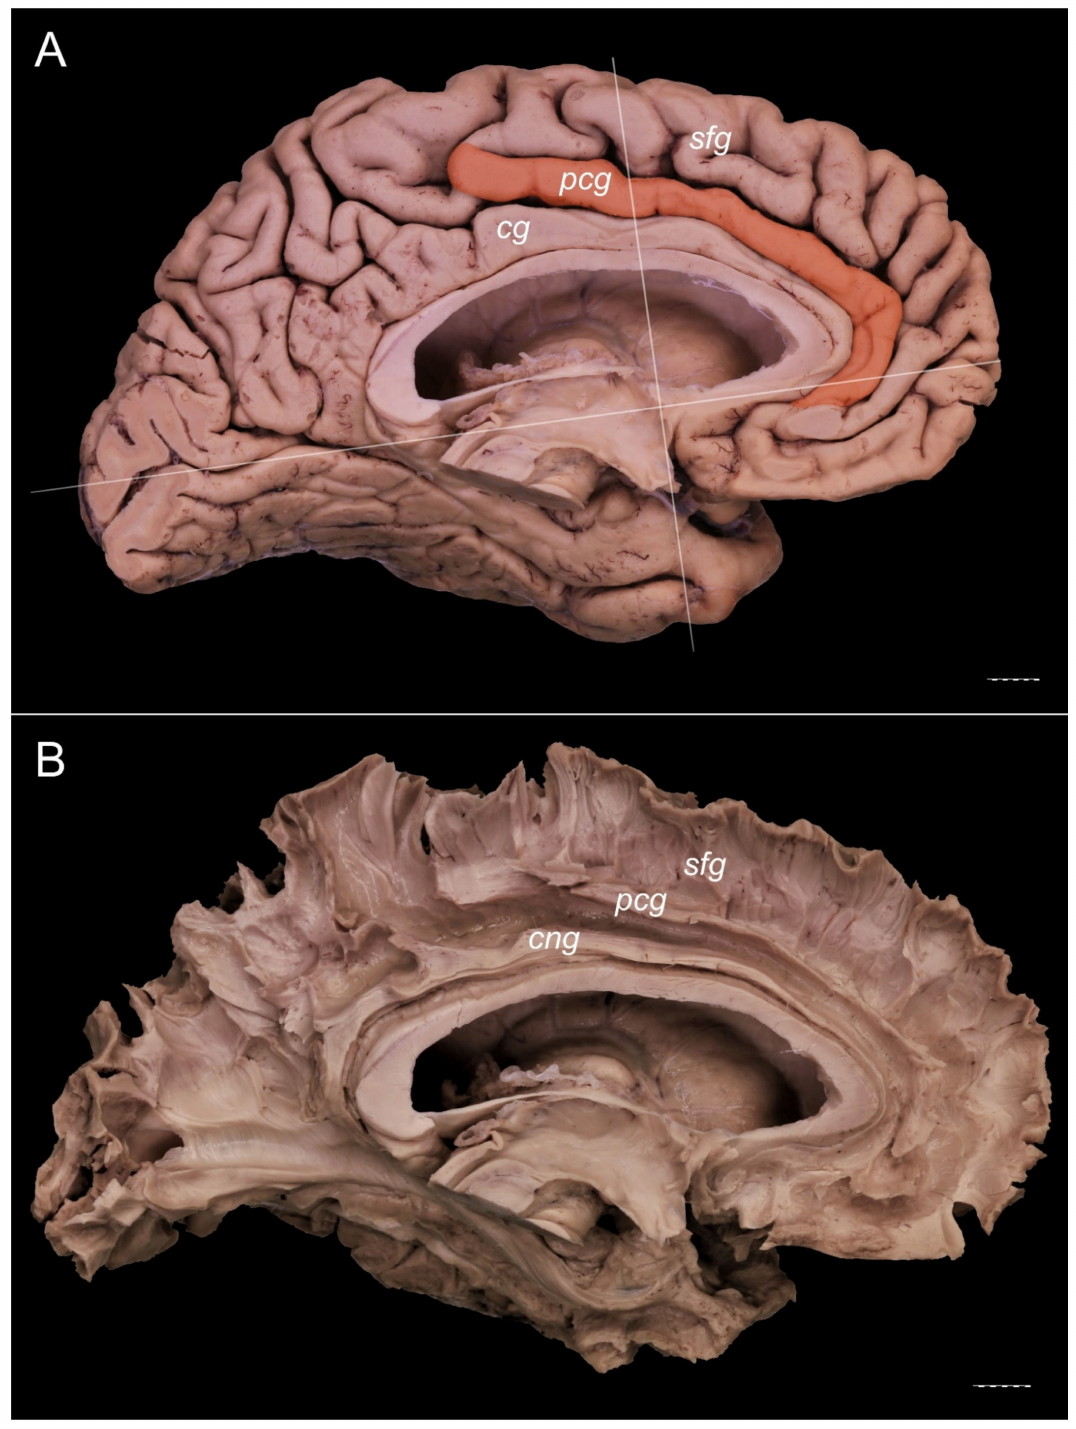
Figure 4. Presence of a prominent PCG. Medial view of the left cerebral hemisphere. The posterior cingulate gyrus crosses the level of the VAC line. No interruption of the gyrus is visible. ( A ) Specimen with a PCG (orange). The VAC and AC-PC lines are marked. ( B ) The specimen seen in Figure 4A, dissected using Klingler’s technique. A separate cingulum and white matter fibers of the paracingulate and superior frontal gyri are well developed. cg—cingulate gyrus; cng—cingulum; pcg—paracingulate gyrus; sfg—superior frontal gyrus. Scale bar corresponds to 10